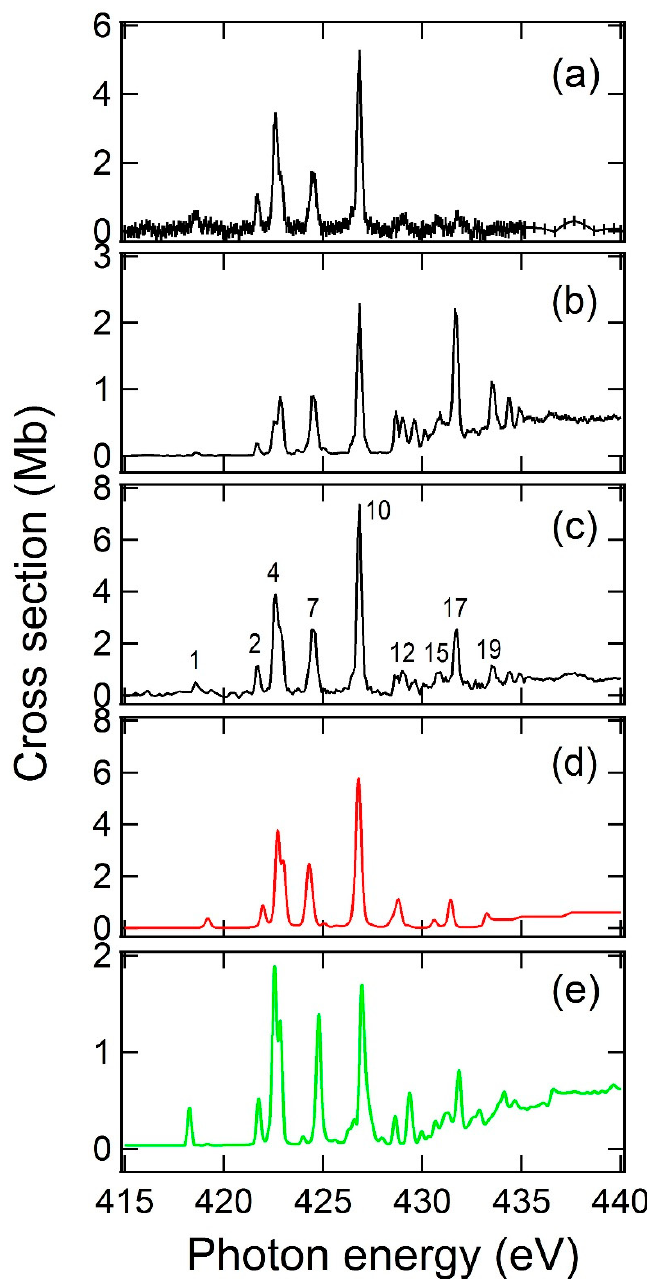
Figure 6. Photoionization cross-sections of the N + atomic ion in the photon energy region of the K-shell threshold (1 s −→ np , n ≥ 3 excitations). ( a ) Absolute measurements in the single-ionisation channel (280 meV band pass). ( b ) Relative measurements in the double-ionisation channel normalised on the data of Figure 5a (250 meV band pass). ( c ) Summation of ( a , b ) with added resonance number labels used in the text of the paper. ( d ) Total photoionization cross-section simulation based on multiconfiguration Dirac-Fock calculations (MCDF). The theoretical energies are shifted by +2.0 eV in the figure. ( e ) Total photoionization cross-section simulation based on R-matrix with pseudo-states theoretical (RMPS) calculations.